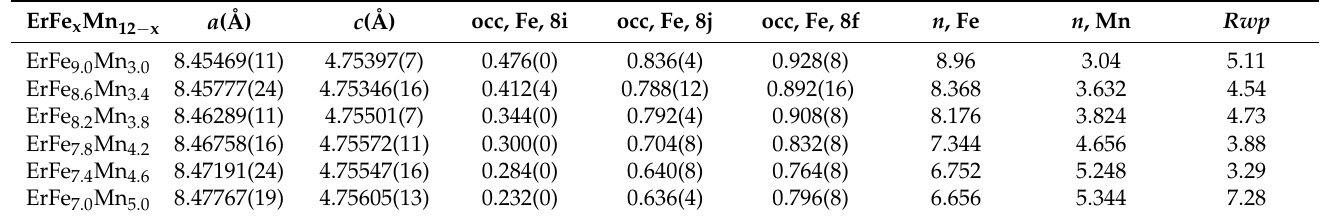
Table 1. Information on crystal structure parameters of ErFe